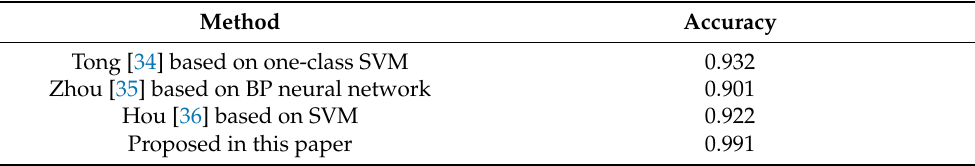
Table 7. Comparison of different